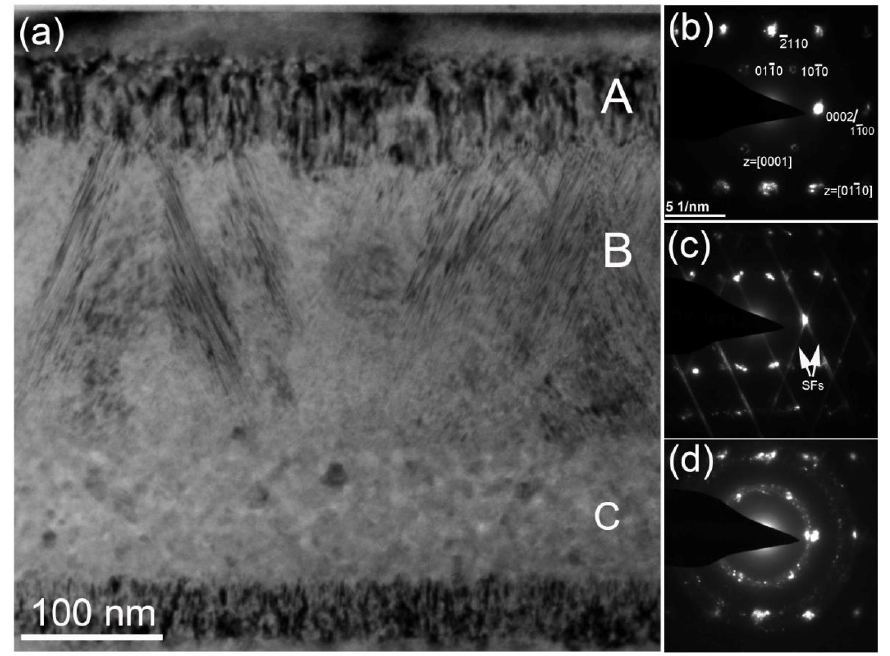
Figure 5. ( a ) Bright-field XTEM image of SiC implanted with the high fluence. ( b ), ( c ) and ( d ) show selected area electron diffraction patterns taken from the A, B and C zones, respectively.